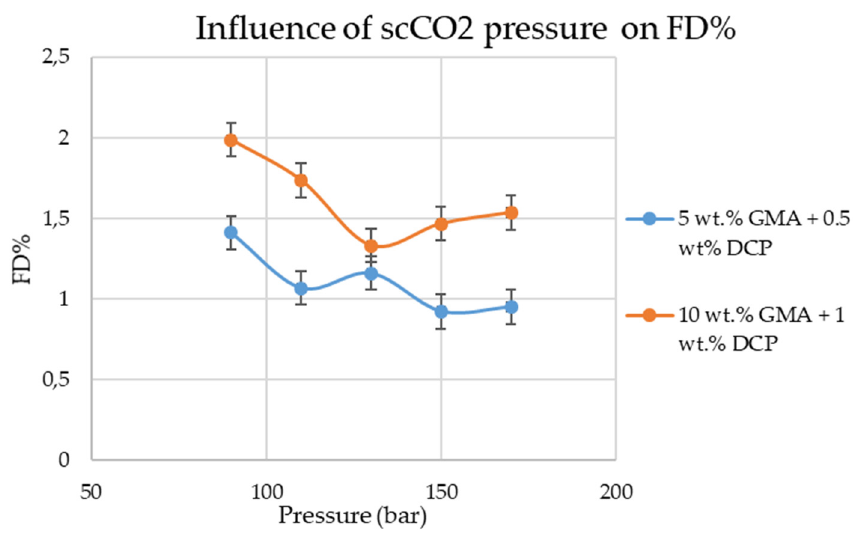
Figure 8. Influence of CO 2 inlet pressure on FD.